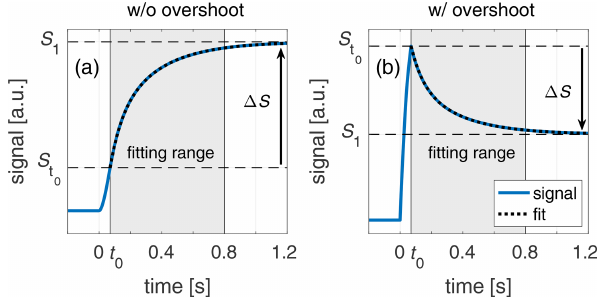
Figure 7. (a) Time constant fitting scheme for a signal with expo- nential decay behaviour without an overshoot; (b) analogously for a signal with an